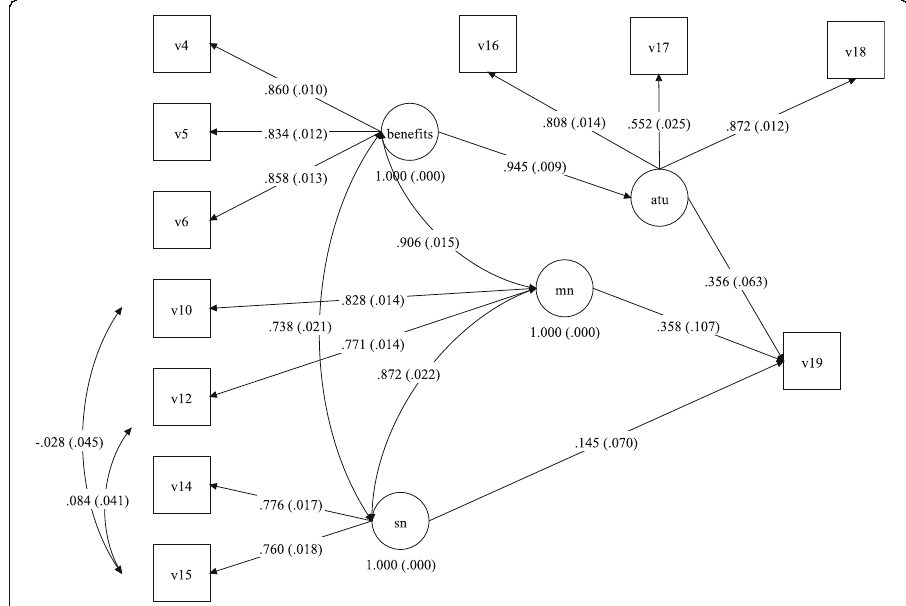
Fig. 11 Final pooled model for ‘ alternative protein source ’ . Standardised parameter estimates are shown with associated standard errors in parentheses